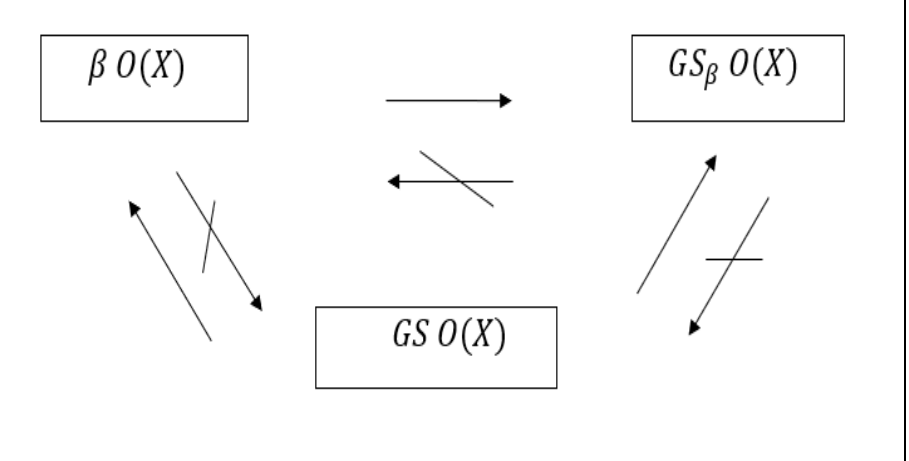
open set, open set and Gril Semi open set. Figure 1. Relationship connecting β open set, GS β open set and Gril Semi open 𝛽𝛽 𝐺𝐺𝐺𝐺 𝛽𝛽